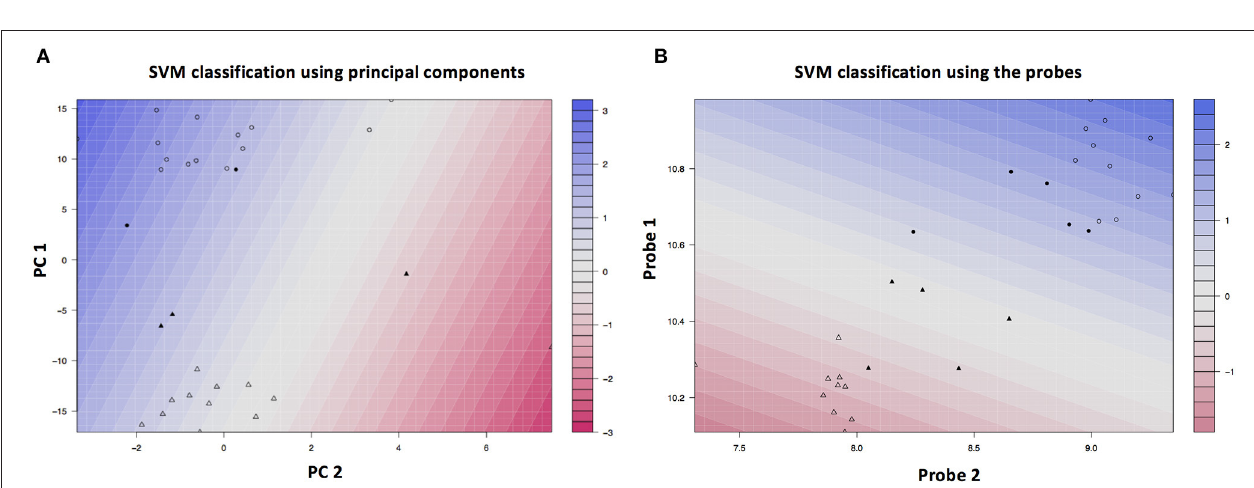
FIGURE 4 | ASD subgroups identified using RF and PAM clustering algorithms. Dim1 and Dim2 correspond to principal components 1 and 2, respectively. (A,B) The results based on the top 10 principal components (PCs) and the 191 probes, respectively. We used the first two predictors to make the plots to demonstrate how different approaches classified the sample.